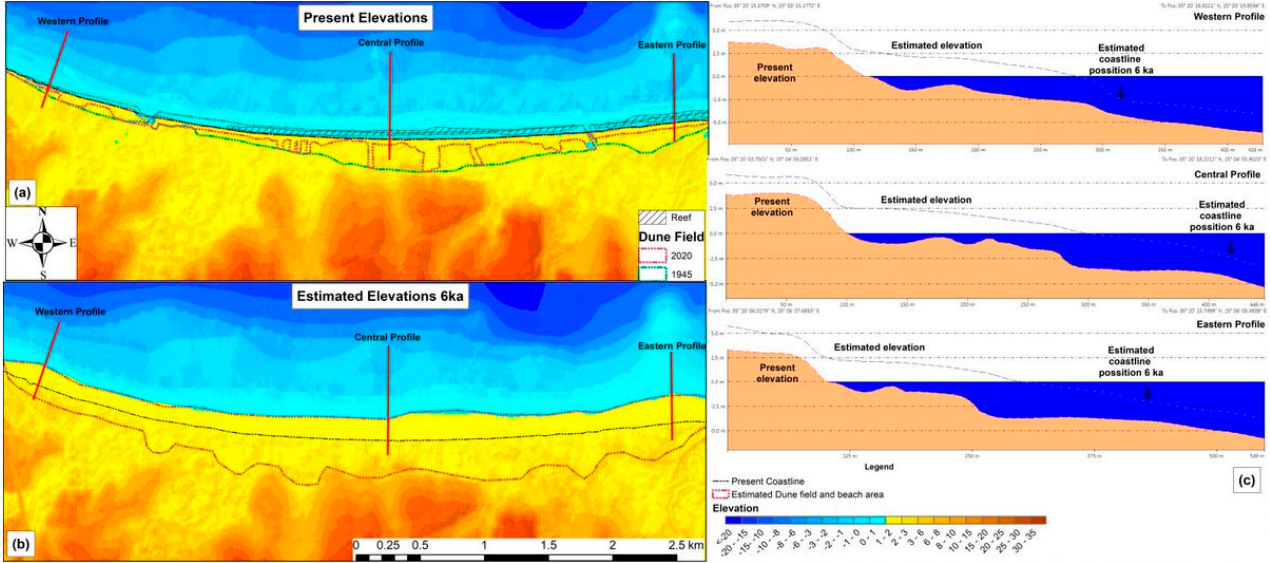
Figure 10. Current elevations, current position of the reef and the coastline, and extent of the dune fields for 1945 and 2020 ( a ). Estimated elevations and estimation of the extent of the dune field 6 ka ( b ). Representative profiles of current and estimated elevation, and estimated shoreline position 6 ka ( c ).